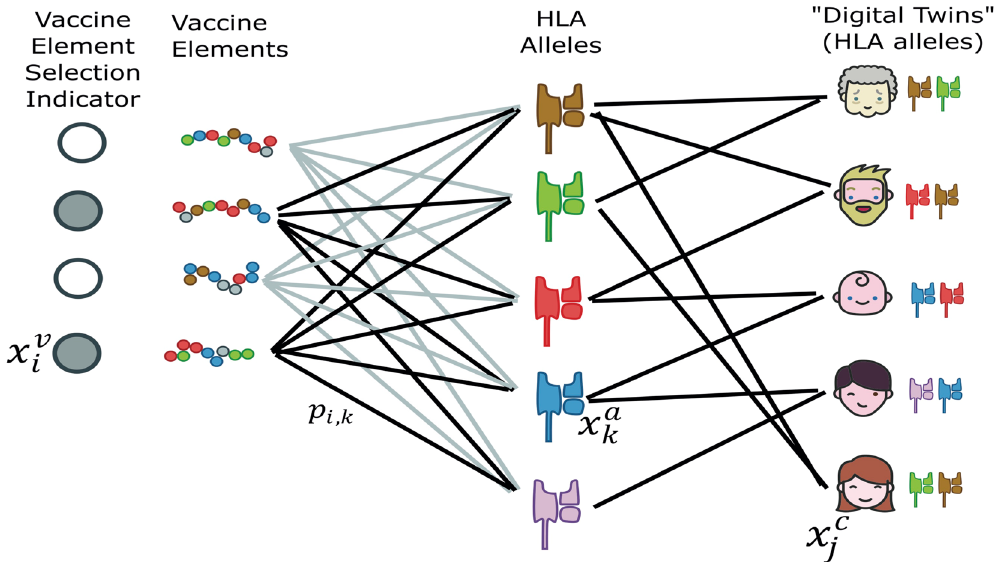
Figure 8. Schematic of the problem setting. The vaccines elements were the significant epitope hotspots that emerged from the statistical hotspot detection